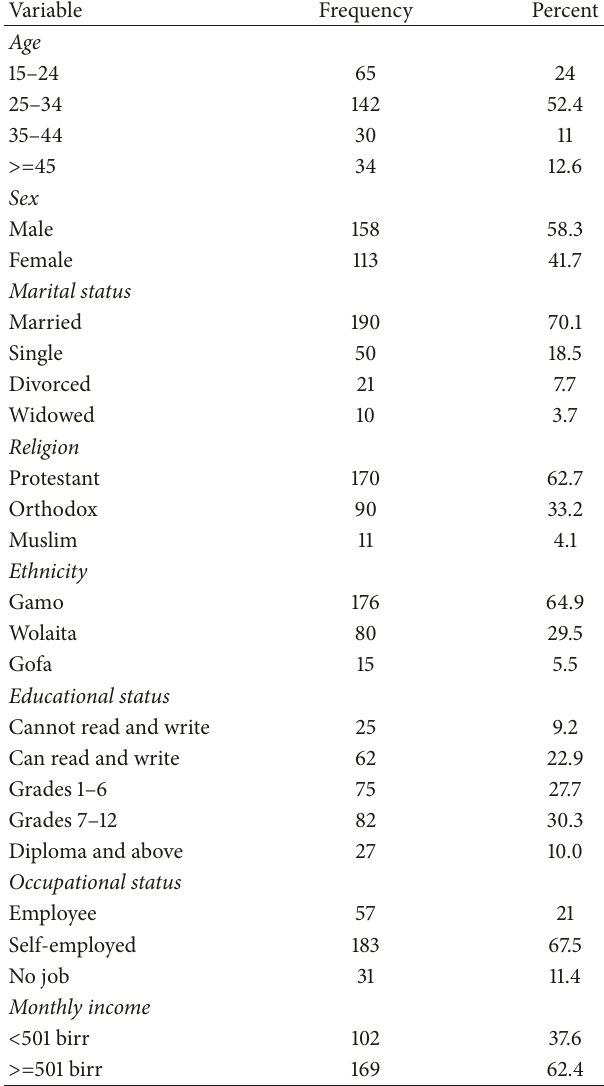
Table 1: Sociodemographic characteristics of the TB patients that attended TB clinics at governmental health institutions of Arba Minch town, Southern Ethiopia, 2017 (𝑁 = 271)